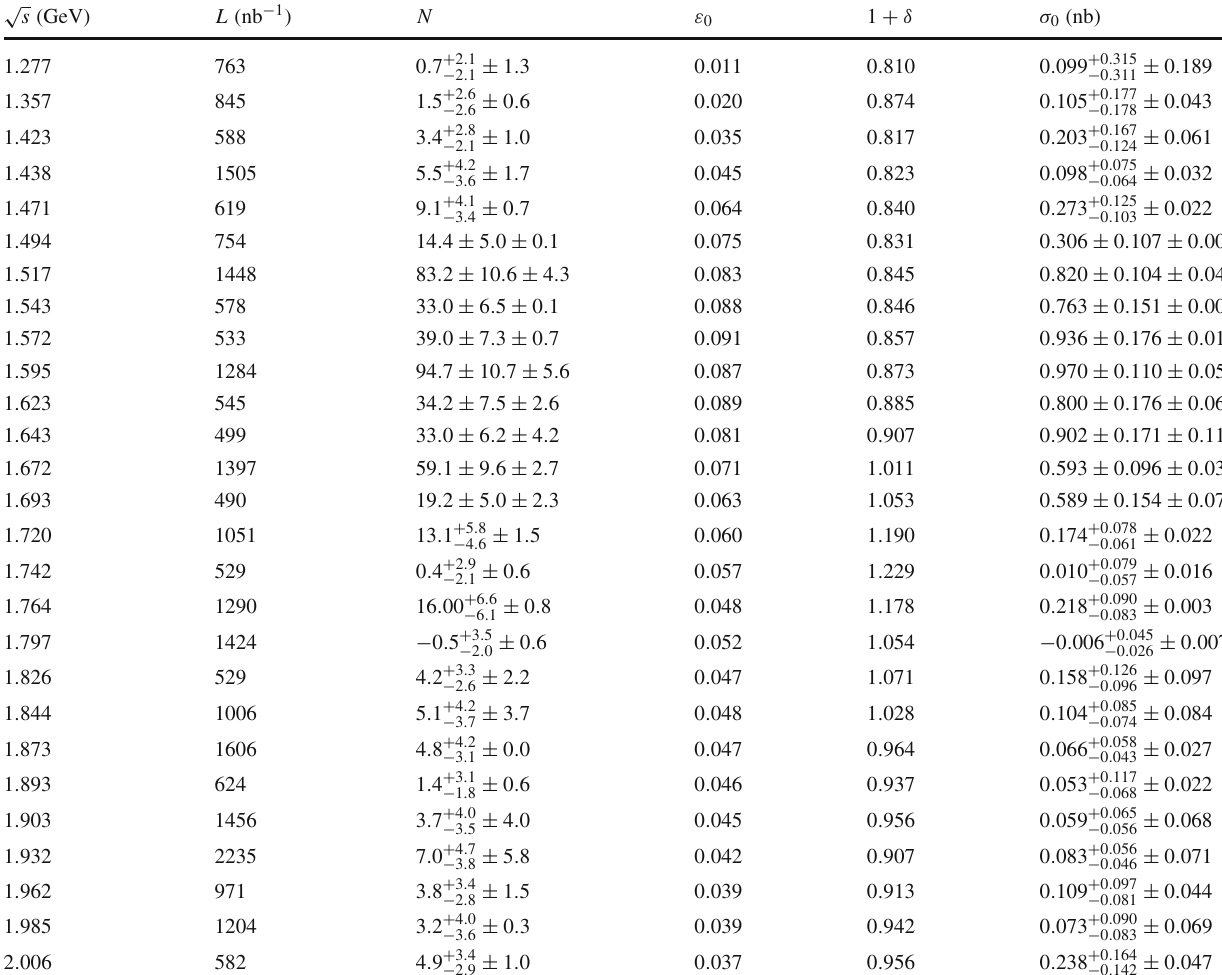
√ s ), integrated luminosity ( L ), fitted num- Table 1 The c.m. energy ( cal and systematic errors are quoted. For the cross section, the second ber of events of e + e − → K + K − π 0 process ( N ), detection efficiency error is the energy-dependent uncorrelated systematic uncertainty. The ( ε 0 ), radiation correction factor (1 + δ ), and Born cross section for the energy independent correlated uncertainty on the cross section is process e + e − → K + K − π 0 ( σ 0 ). For the number of events, statisti-